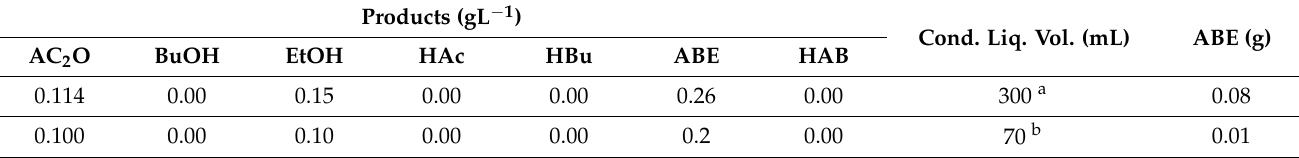
Cond. Liq. Vol. (mL) ABE (g)